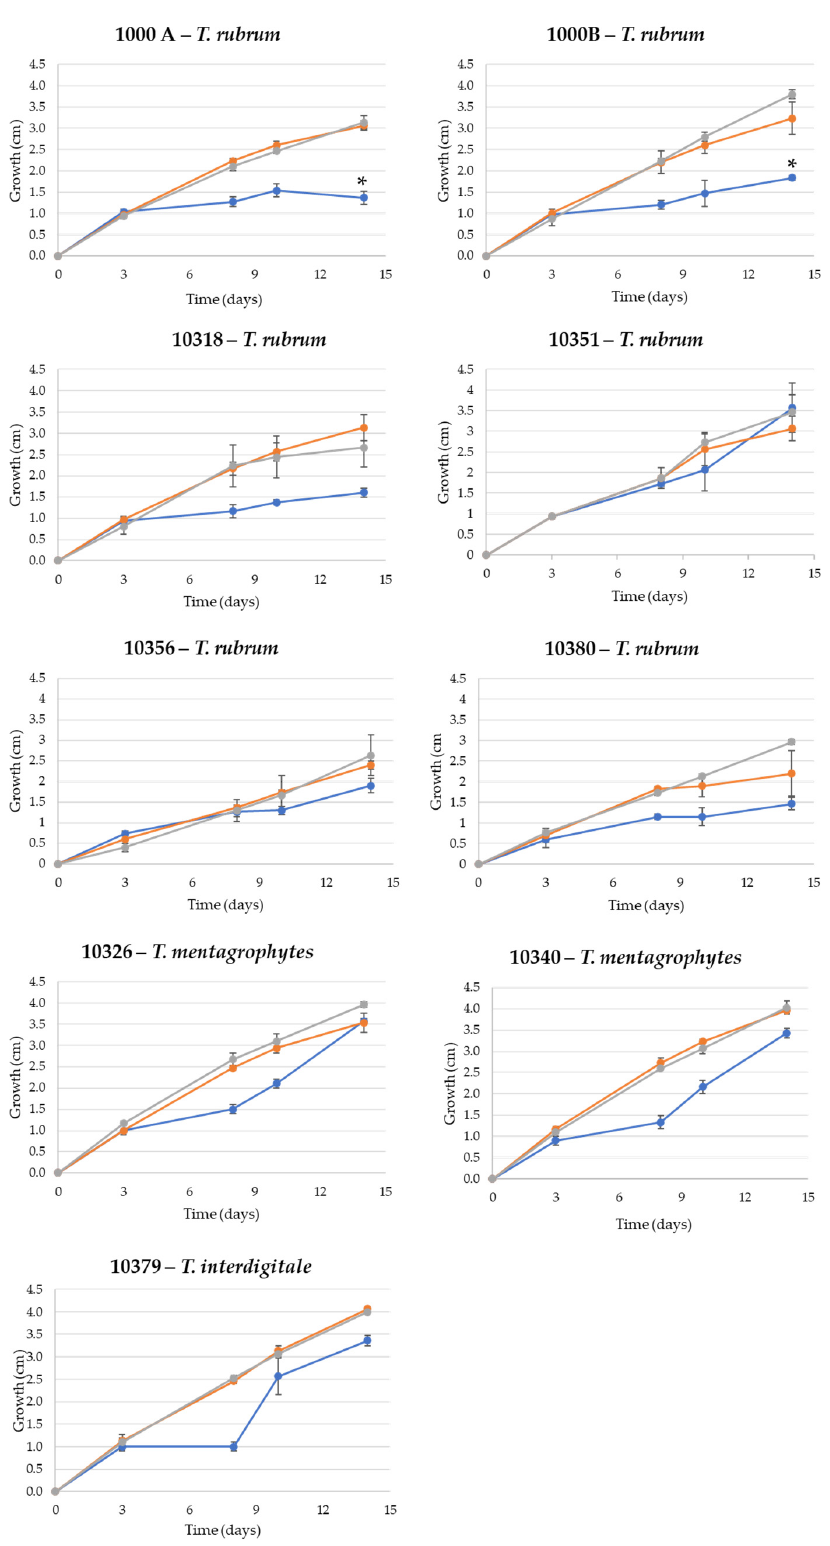
Figure 3. Growth tests of T. rubrum (1000A, 1000B, 10318, 10351, 10356, and 10380), T. mentagrophytes (10326 and 10340), and T. interdigitale (10379) in WA (blue), ½ SDA (orange), and SDA (grey). Error bars indicate the standard deviation of the three replicates used for the tests. ANOVA tests were performed, and statistically significant differences are marked with *.